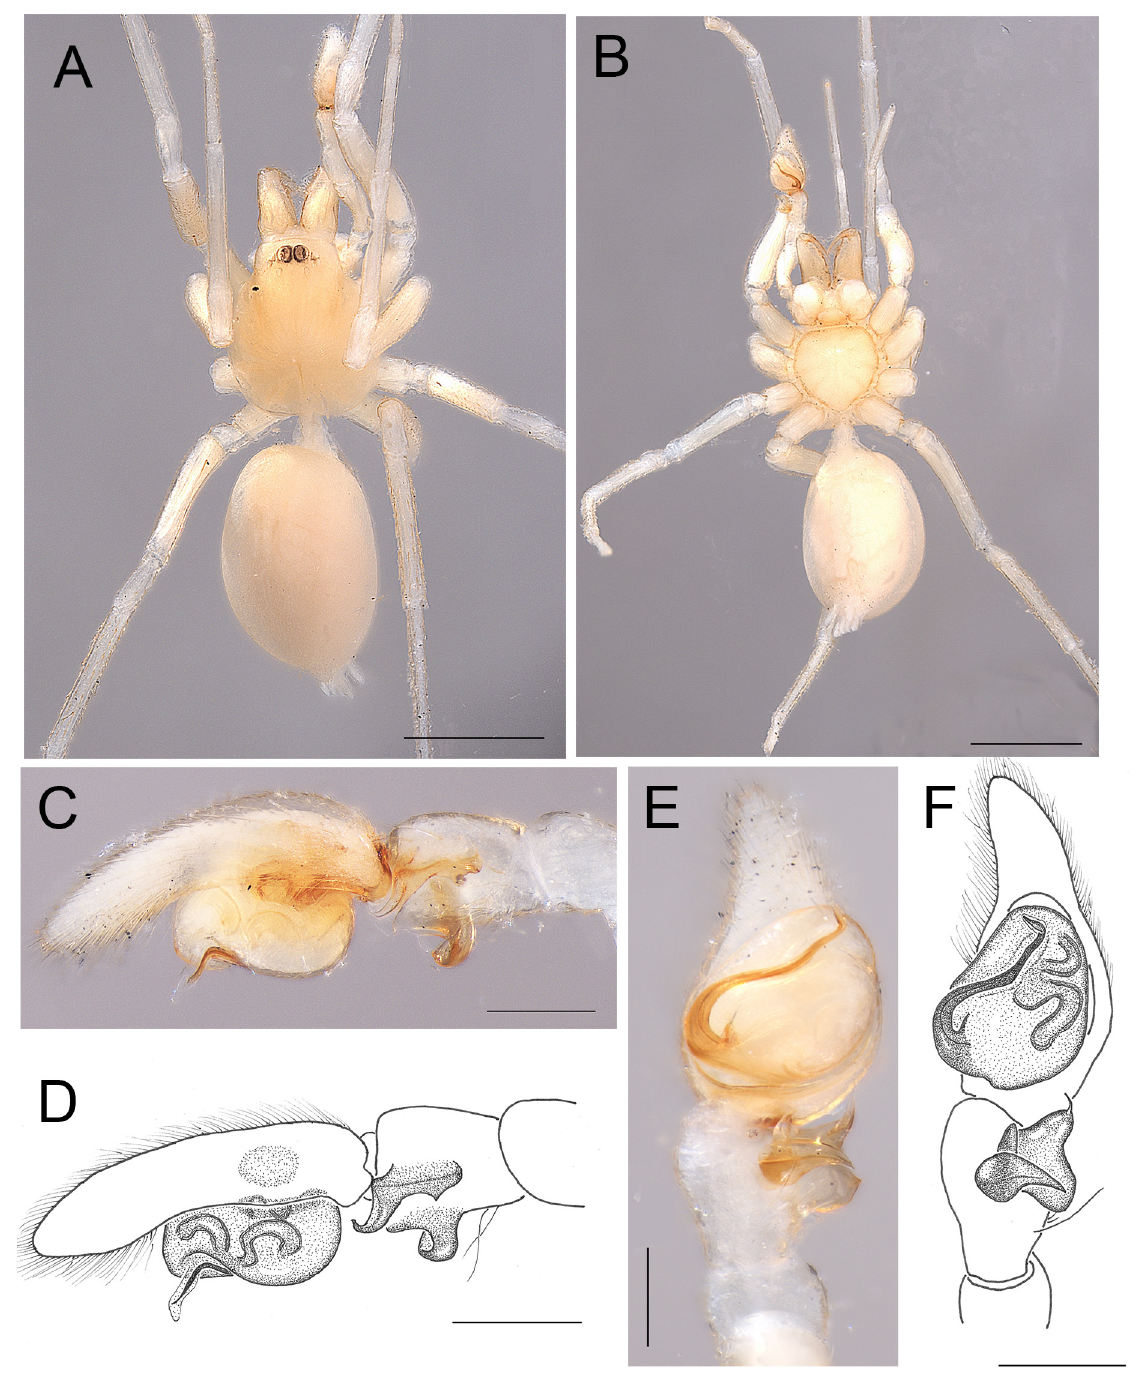
Fig. 10. Andromma anochetorum Simon, 1909, ♂, holotype (MNHN AR3112). A . Habitus, dorsal view. B . Same, ventral view. C–D . Left palp, retrolateral view. E–F . Same, ventral view. Scale bars: A–B = 1 mm; C, E = 0.2 mm; D, F =